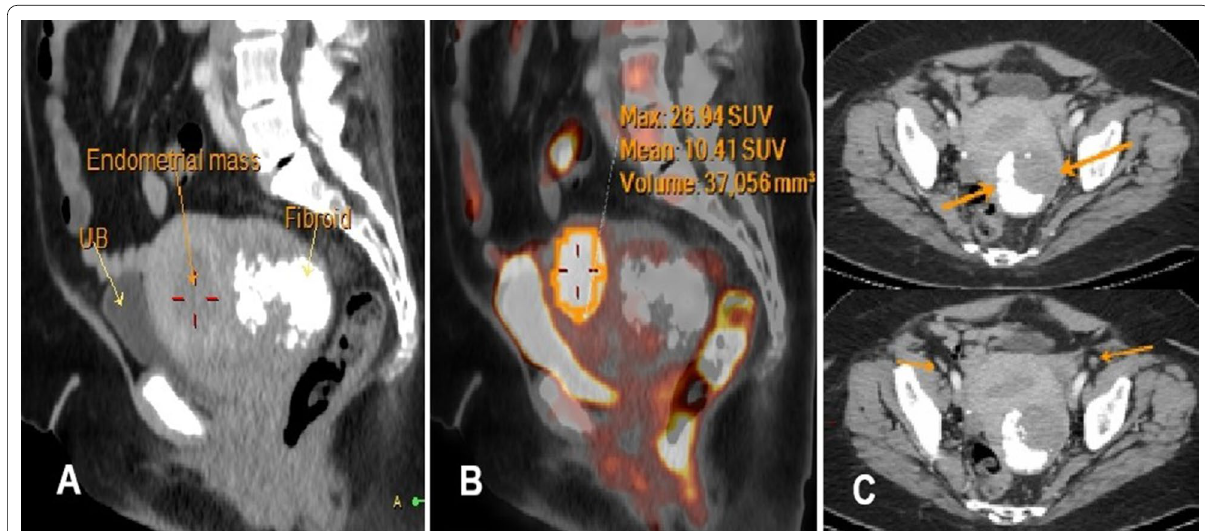
Fig. 1 The uterus is enlarged, showing endometrial intensely avid heterogeneous soft tissue lesion, measuring The myometrium shows few fibroids, and the largest one [measuring dystrophic calcifications. The endometrial lesion achieves 26.9 SUV max , 10.4 SUV mean and MTV